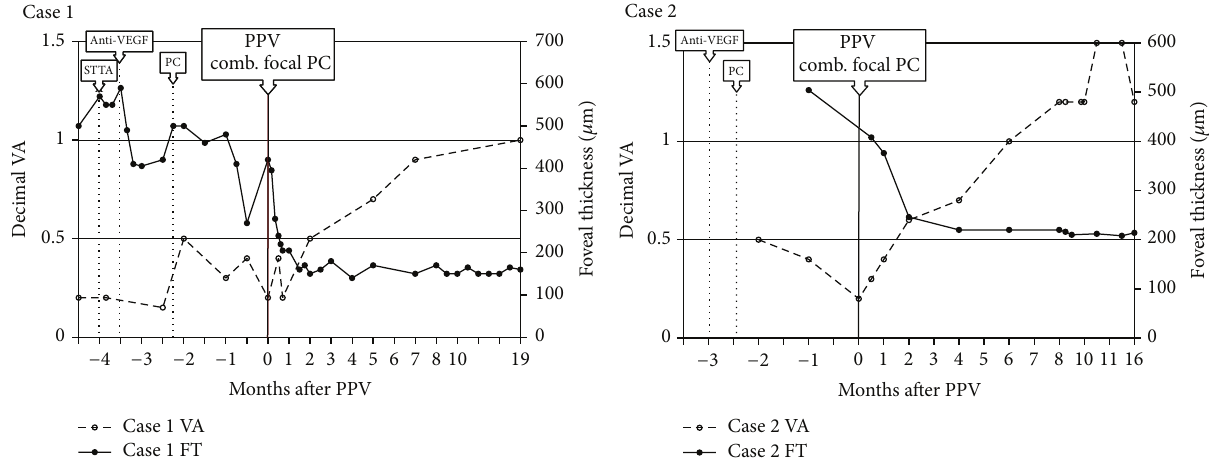
Figure 3: Clinical course of the affected eyes in two cases of MacTel type 1. In Case 1, the visual acuity improved to 20/20 and foveal thickness was reduced to 140 𝜇 m at 19 months after surgery. In Case 2, the visual acuity improved to 20/13 and foveal thickness to 208 um at 13 months after surgery.